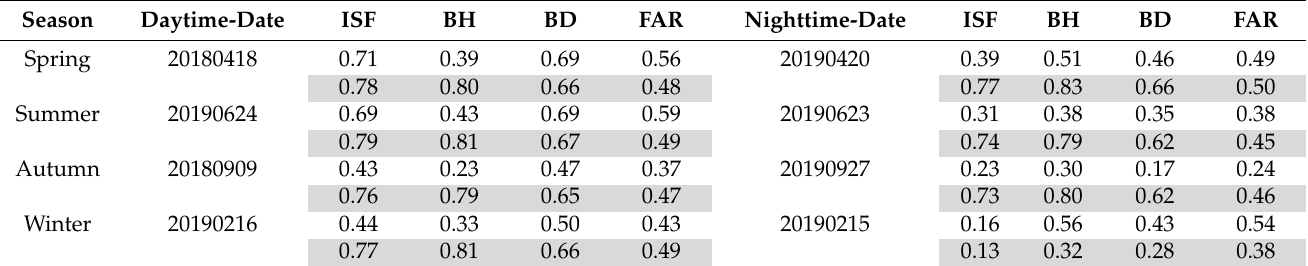
Table 6. The relationship between the selected morphology factors and LST by Pearson correlation coefficient (white lines) and local R 2 values of the MGWR (gray lines).